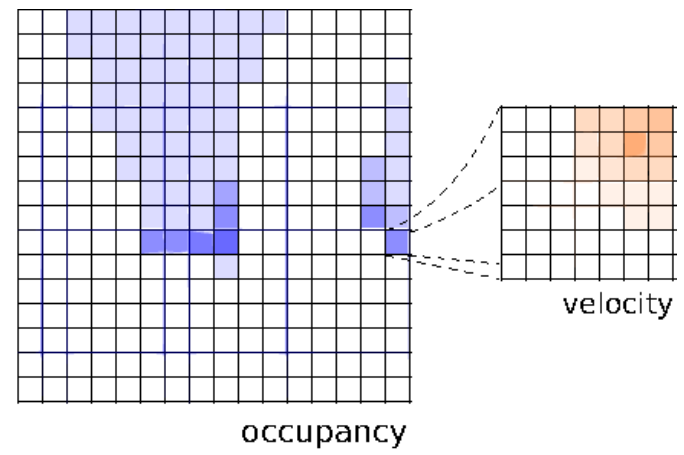
Figure 4. BOF representation from [13]: A two-dimensional grid where each cell has an occupancy value and a histogram of possible velocities. Reproduced with permission from reference [13]. Copyright 2014